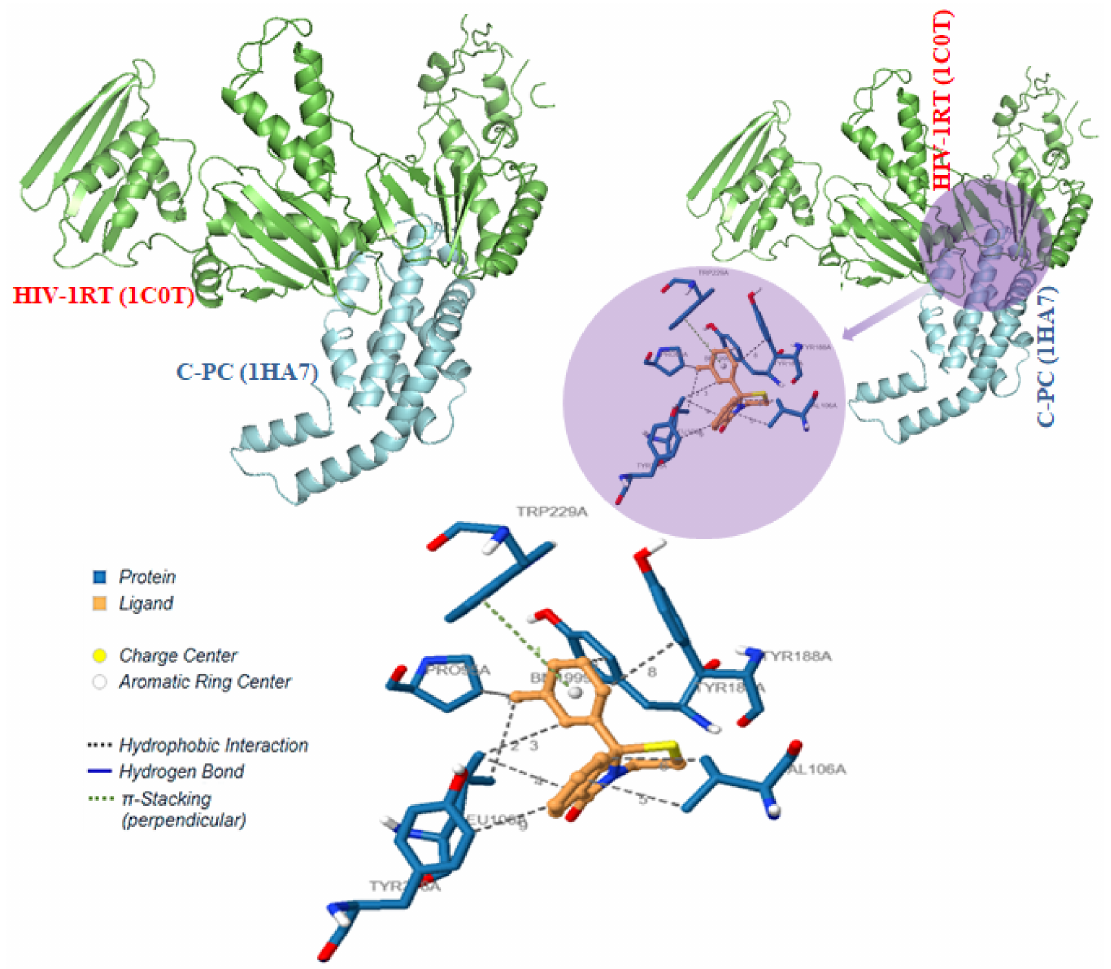
Figure 3. Molecular interactions between C-PC (1HA7) with HIV-1 Reverse Transcriptase (1C0T). HIV-1RT (green) active residues as well as other important residues are occupied by C-PC (aqua blue) and therefore inhibit the reverse transcription activity.